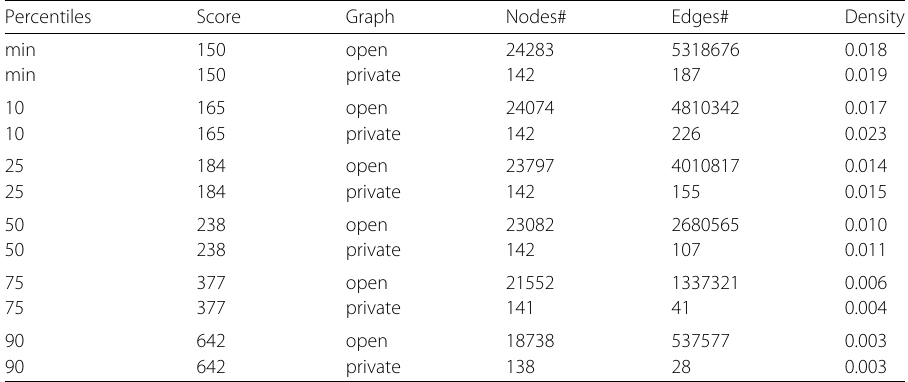
Table 16 Global measures values of the proteins-proteins networks extracted from the STRING data base and the private networks, according to combined score percentiles Percentiles Score Graph Nodes#